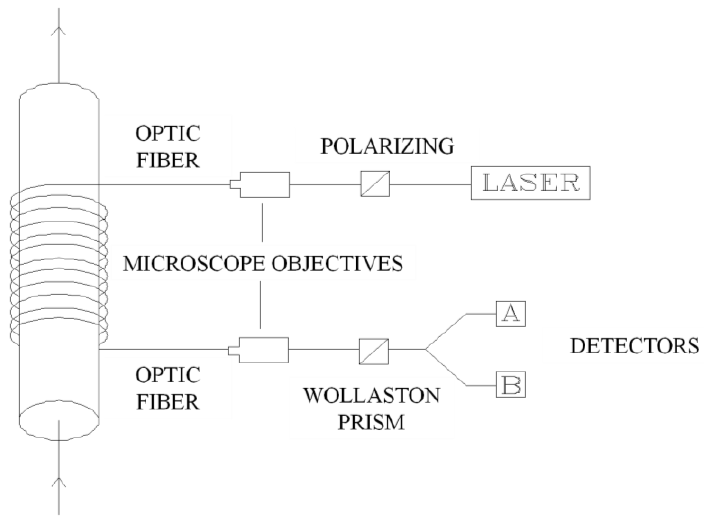
Figure 5. Current sensor based on material length variation with magnetic